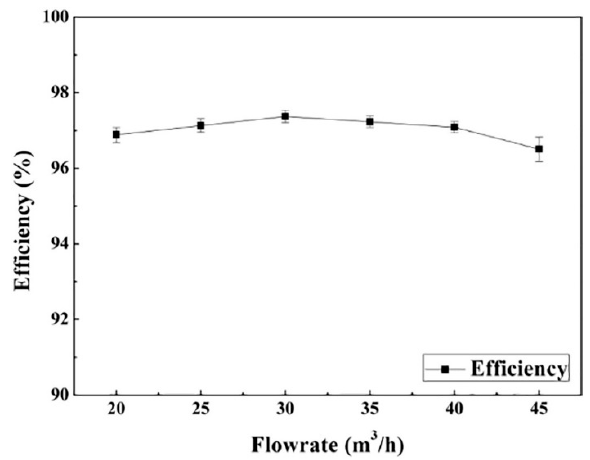
Figure 8. The energy recovery efficiency in different capacities [ Error! Reference source not found. ].